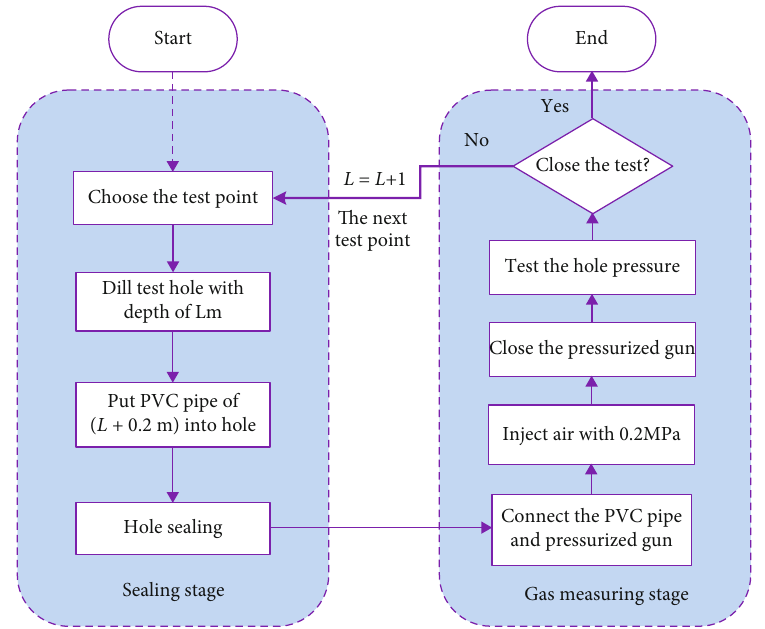
Figure 3: Test process of the gas attenuation method.